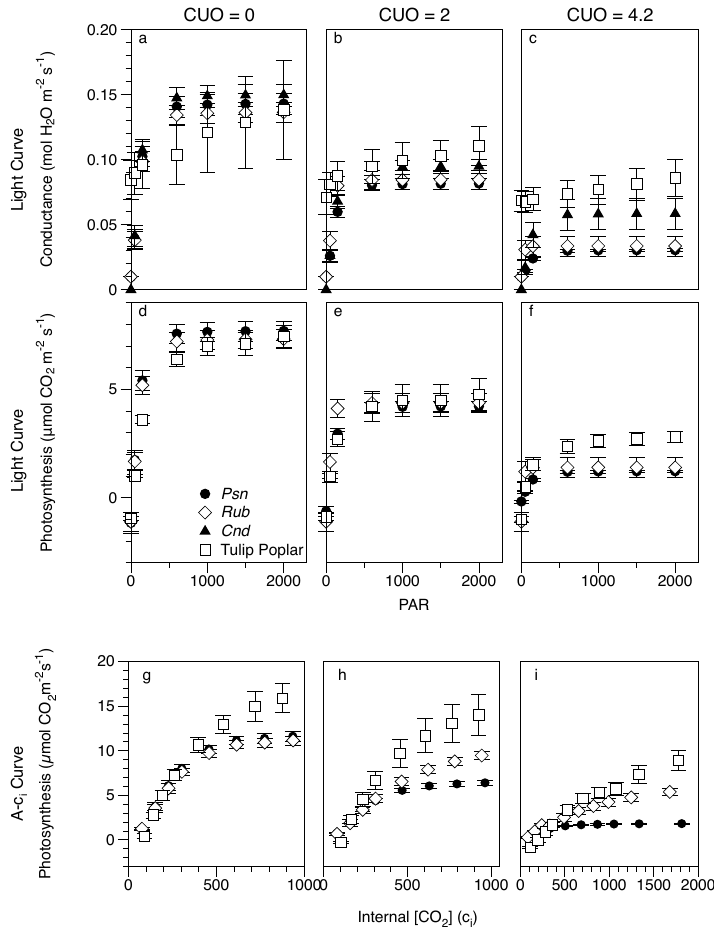
Fig. 2. Mean light and A − c i curves predicted by different Farquhar/Ball-Berry model parameterizations compared with observed tulip poplar responses at various cumulative O 3 uptake (CUO) values. Simulations were run before the effects of O 3 – CUO=0; (a) , (d) , and (g) ; at CUO of 2mmolm − 2 – (b) , (e) , and (h) ; and at a CUO of 4.2 – (c) , (f) , and (i) . The Cnd model predicts observed stomatal conductance responses to different light values – (a) – (c) – more accurately than the Psn or Rub models. The Rub model predicts observed photosynthetic responses to light – (d) – (f) – more accurately than the Psn model. Neither model predicts observed photosynthetic responses to A − c i – (g) – (i) – as accurately as light, though the Rub model predicts A − c i curves more accurately than the Psn model. Error bars represent mean standard error. See Table 2 for a description of the